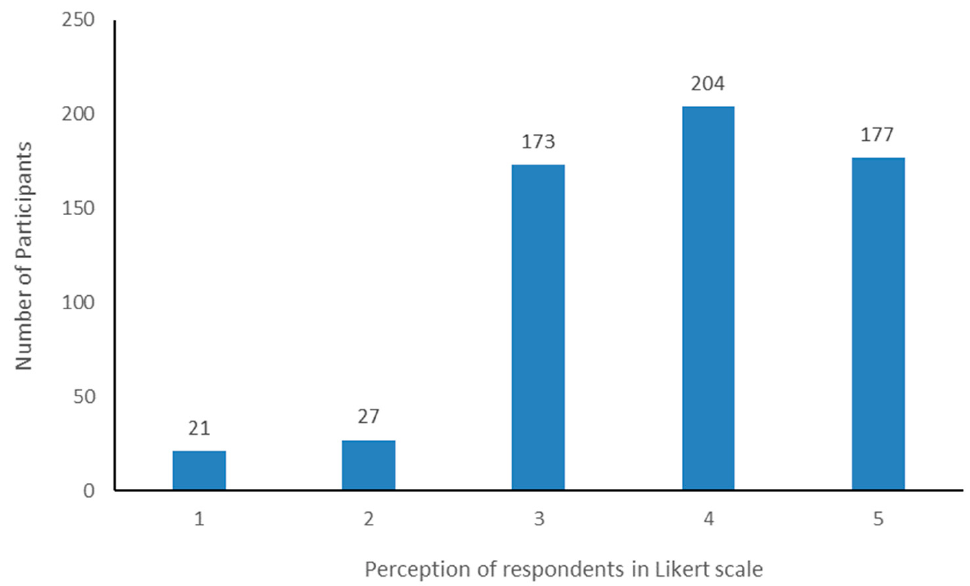
Figure 1. Perception of respondents toward the question “Can vaccines prevent COVID-19 infection?” in Likert scale (1: strongly disagree; 2: disagree; 3: neutral; 4: agree; and 5: strongly agree).